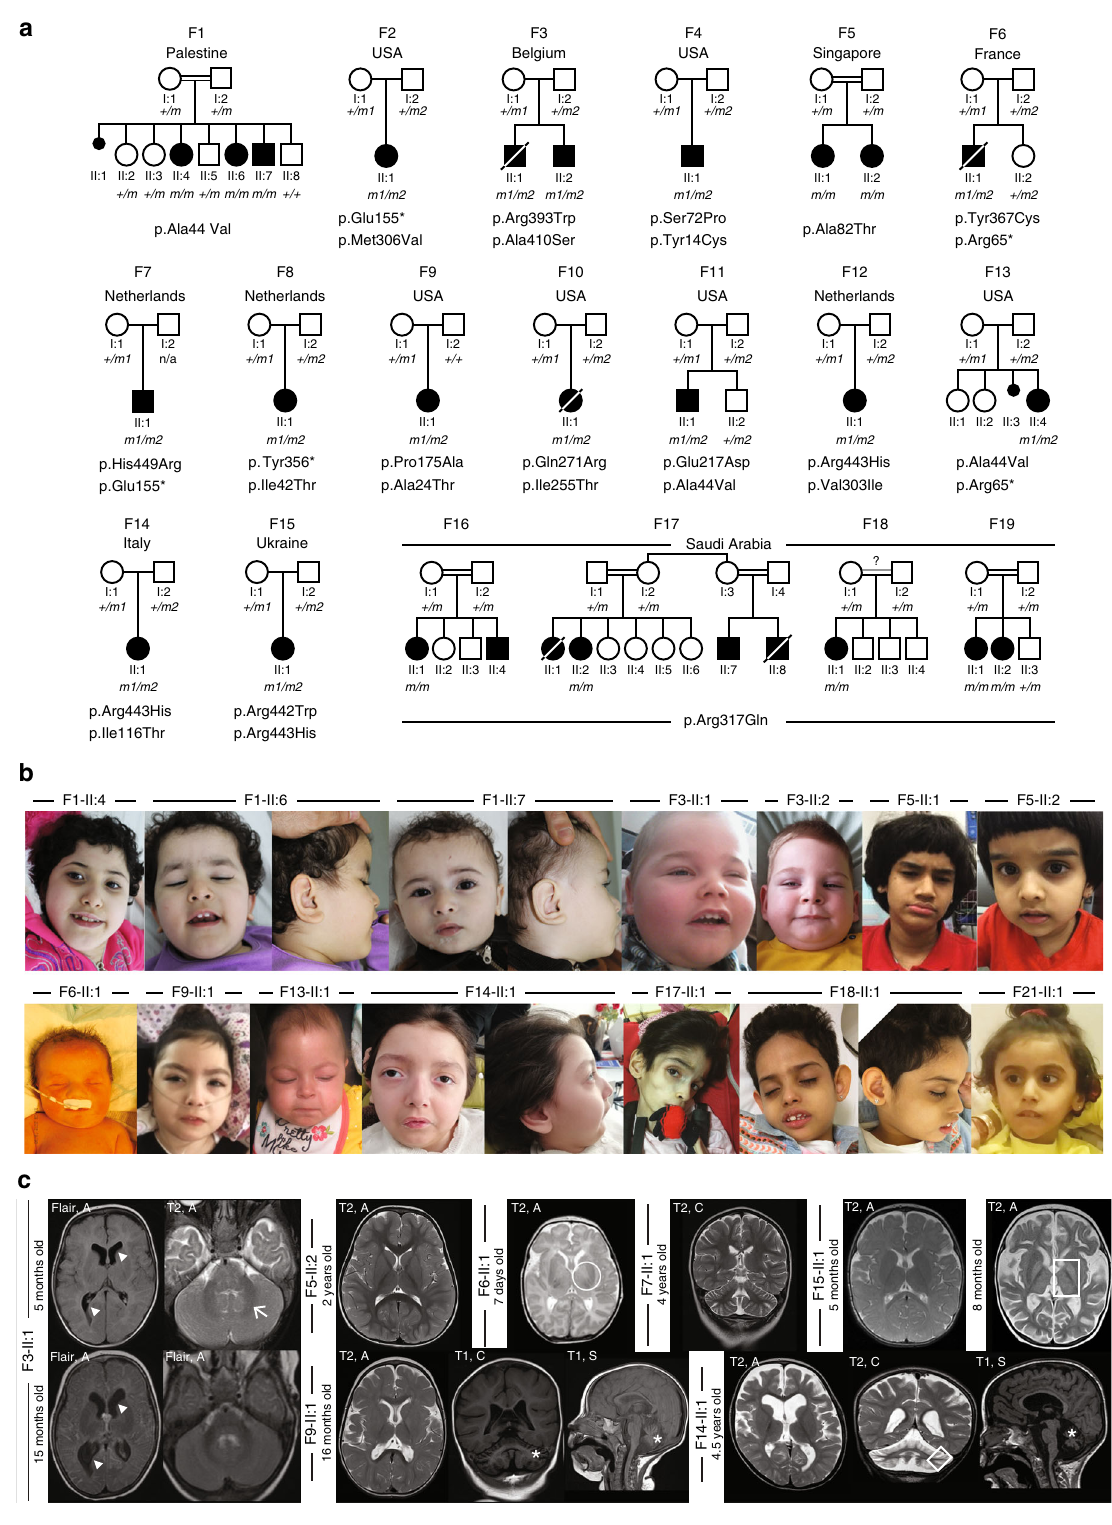
endogenous UGDH protein levels for three of the four alleles studied. Fibroblasts with compound heterozygous R393W/A410S mutations displayed comparable UGDH levels relative to wild-type (WT) cells, while patients ’ cells with